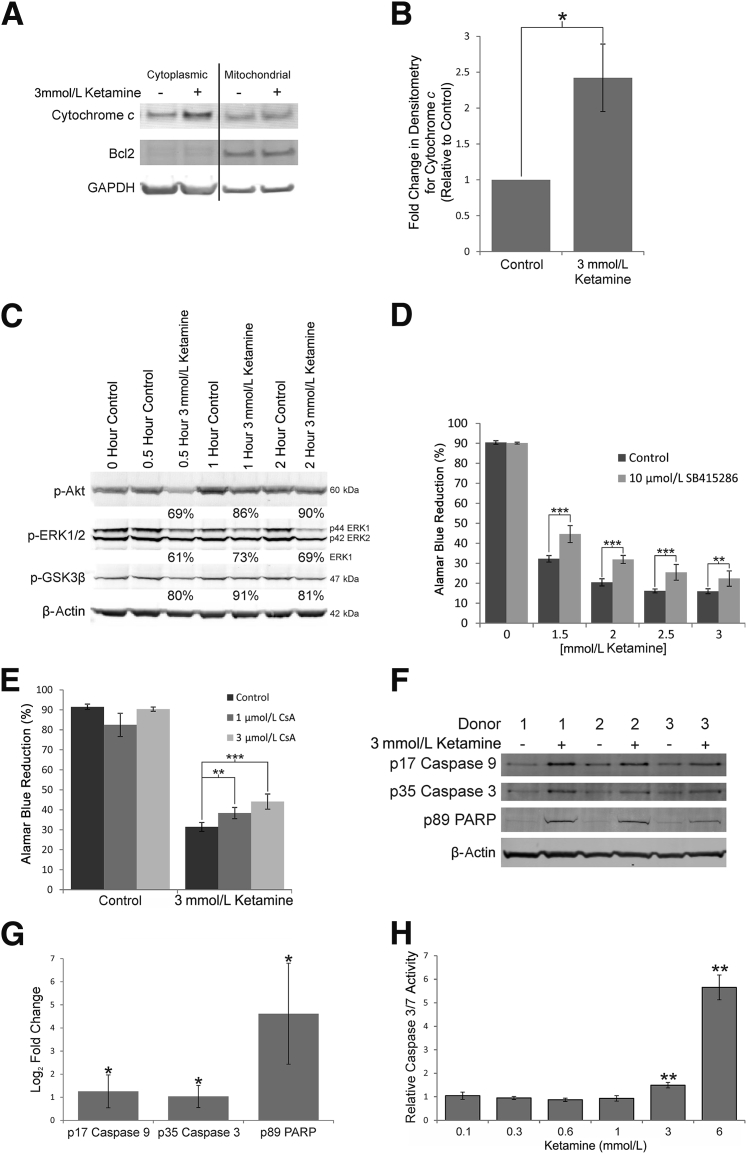
Induction of apoptosis in normal (nonimmortalized) human urothelial (NHU) cell cultures by ketamine. A: Western blot analysis of NHU cells separated into cytoplasmic and mitochondrial fractions showed elevated cytochrome c in the cytosolic fractions of cultures treated with 3 mmol/L ketamine for 24 hours. Loading controls were Bcl2 for the mitochondrial fraction and glyceraldehyde-3-phosphate dehydrogenase (GAPDH) for the cytoplasmic fraction. B: Densitometry analysis showed a significant mean 2.4-fold change in cytoplasmic cytochrome c content in three independent NHU cell lines after 24 hours' exposure to 3 mmol/L ketamine. C: Western blot analysis of phospho-Akt (active form), phospho-ERK1/2 (active form), and S9 phospho-glycogen synthase kinase (GSK) 3β (inactive form) showed early depletion of these forms of the kinases in response to 3 mmol/L ketamine. Abundance quantified by densitometry is shown as a percentage of control cells for each time point, normalized to β-actin (combined data). D: Inhibition of GSK3β by SB415286 in ketamine-exposed NHU cells was capable of a slight, but significant, inhibition of toxicity, as assessed by Alamar Blue reduction. E: Inhibition of the mitochondrial permeability transition pore with cyclosporin A (CsA) in ketamine-exposed NHU cells was capable of a small, but significant, inhibition of toxicity, as assessed by Alamar Blue reduction. F: Western blot analysis of caspase 9, caspase 3, and cleaved poly (ADP-ribose) polymerase (PARP) in NHU cells after 72 hours' exposure to 3 mmol/L ketamine. G: The three markers of apoptosis were all significantly increased by more than twofold in densitometry, which was normalized to β-actin. H: Caspase 3/7 activity was assessed in lysates from NHU cell cultures exposed to 0.1 to 6 mmol/L ketamine and normalized to baseline caspase activity in untreated cells. Significant increases in caspase activity were observed after exposure to 3 and 6 mmol/L ketamine. Error bars represent SD (B, D, E, G, and H). n = 4 donors (C); n = 6 (D, E, and H); n = 3 donors (B and G). ∗P < 0.05, ∗∗P < 0.01, and ∗∗∗P < 0.001.